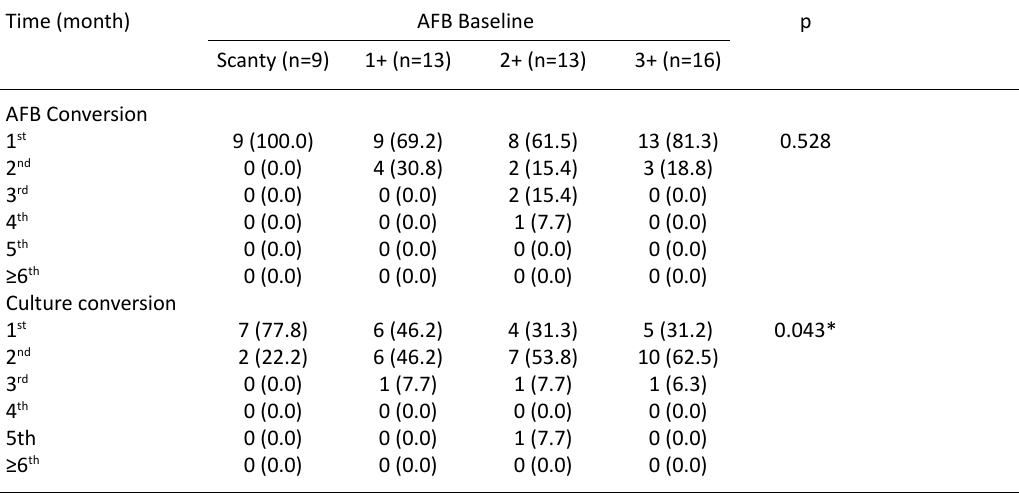
table 3. Correlation of AFB baseline sputum on time to AFB conversion and culture conversion